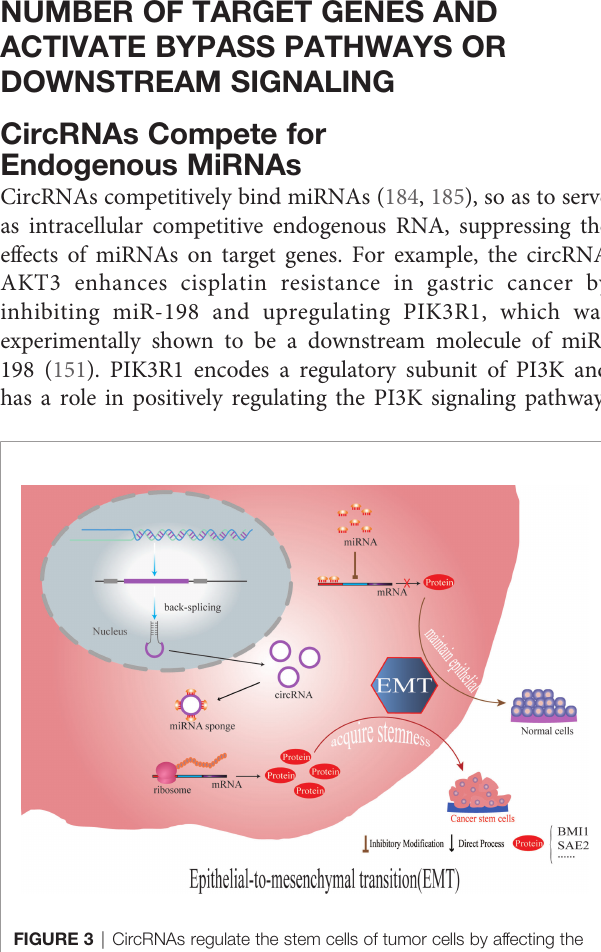
FIGURE 2 | CircRNAs inhibit miRNA function throug1h the molecular sponging mechanism, increasing ABC expression and drug ef fl ux to increase tumor cell drug resistance. The protein with * has been proven to be an ABC- related transcription factor, but there is no literature to prove that it is regulated by circRNA.